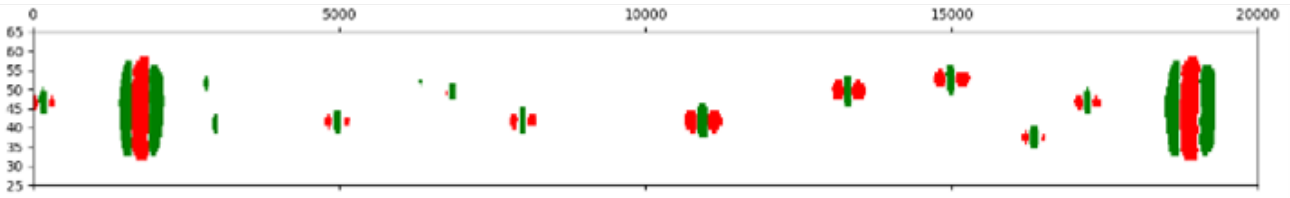
Figure 4. Representative conveyor belt—magnetic analysis of